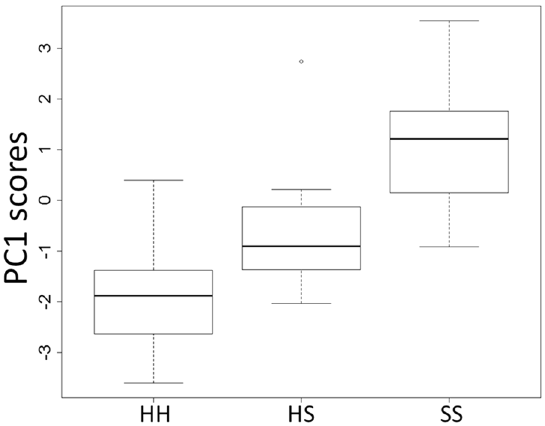
Figure 5. The first axis of the principal component analysis performed on the oxidative status biomarkers was able to discriminate the three study groups (indicated on the x axis by the acronyms HH, HS, and SS). The SS group had significantly higher PC1 scores than both the HS and the HH groups ( P <